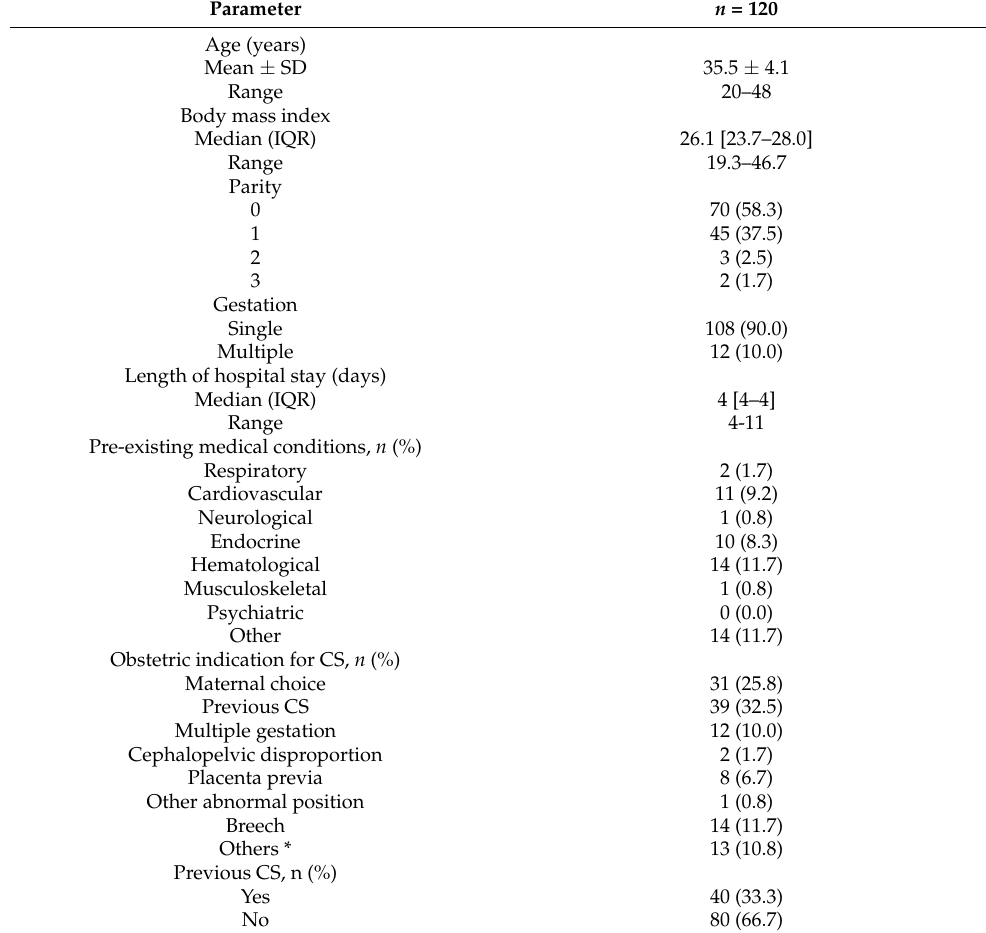
Table 1. Demographic and clinical characteristics of women completing the ObsQoR-11K questionnaire.